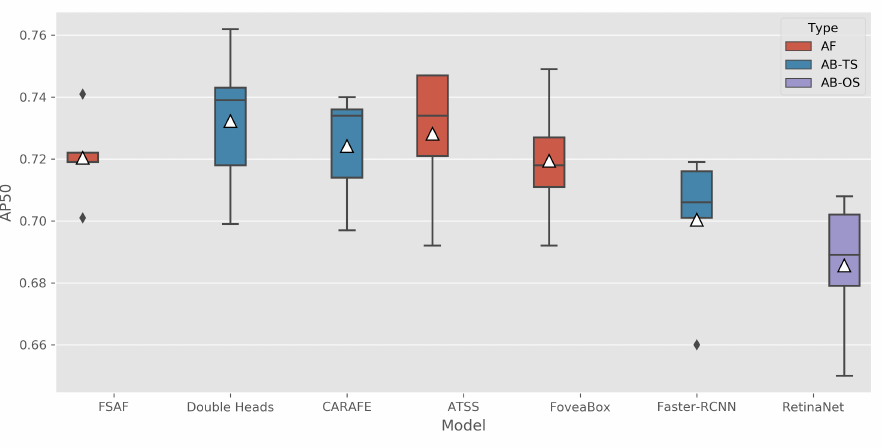
Figure 11. Boxplot for the best five methods plus Faster R-CNN and